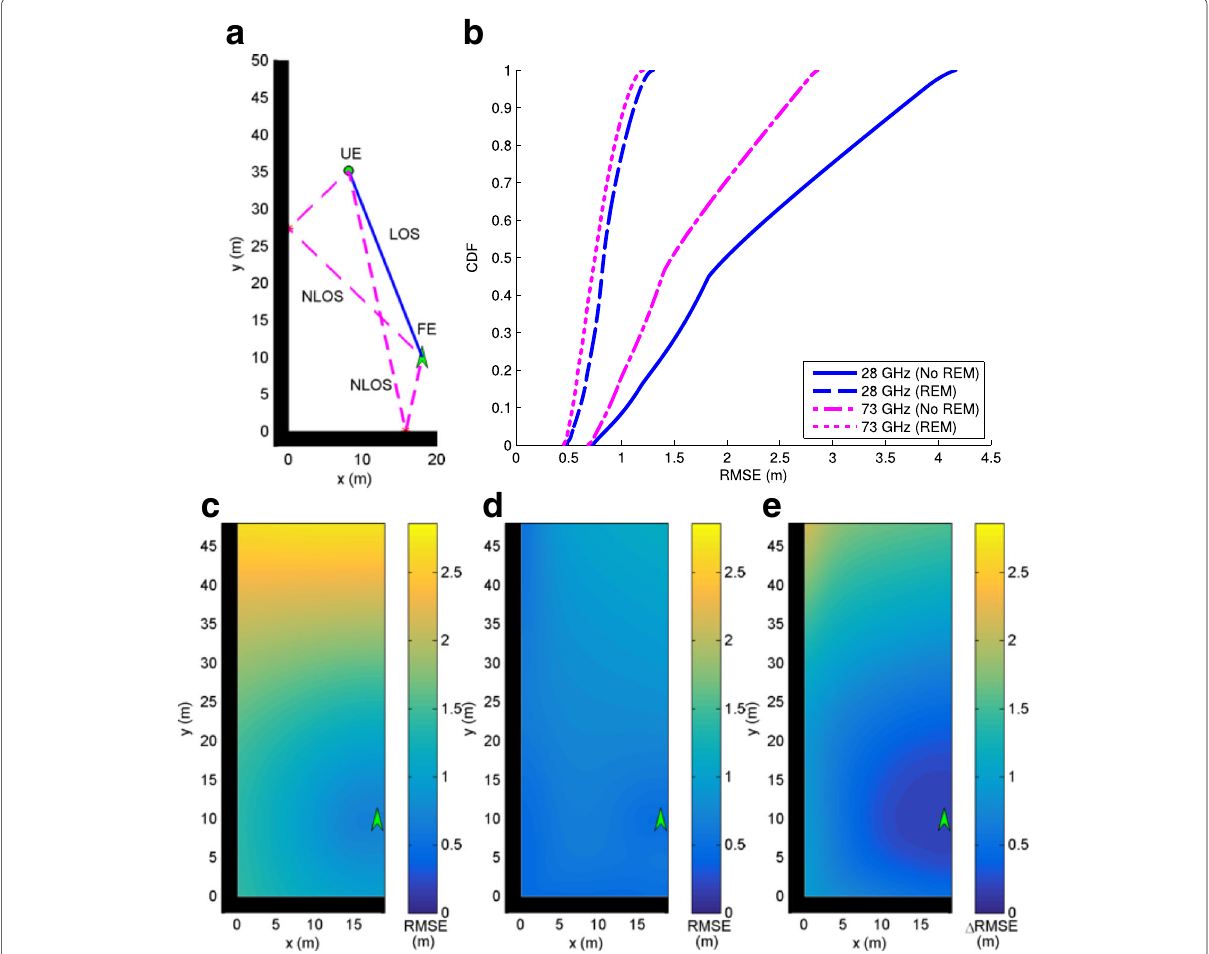
Fig. 8 a Urban corner with one FE, one LOS path, and two NLOS paths. b CDF of RMSE. c RMSE at 73 GHz without REM. d RMSE at 73 GHz with REM. e Improvement in RMSE with REM at 73